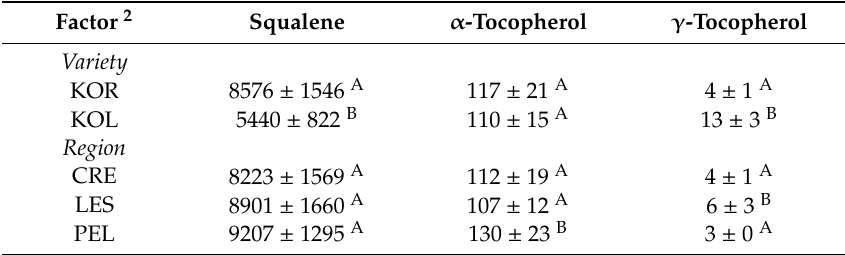
Table 1. Content 1 of squalene and tocopherols (expressed as mg/kg, mean ± standard deviation) in monovarietal extra virgin olive oils from different regions of Greece.